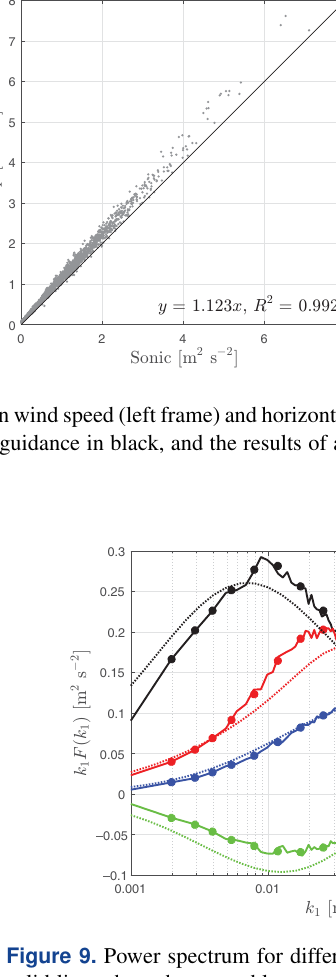
Althoughthevariancesofavelocitytimeseriessampledovera10-minperiodatafrequency f s of0.2or0.06Hzarenotstatis- tically different from those estimated from 1 or 10 Hz records, aliasing and noise might appear both in the sonic-anemometer 10 and the lidar radial velocity spectra. Figure 10-left shows the Avent radial velocity spectrum that has been ensemble-averaged from all the 10-min observed spectra for each of the beams. We conjecture that the increase in the spectral densities at high